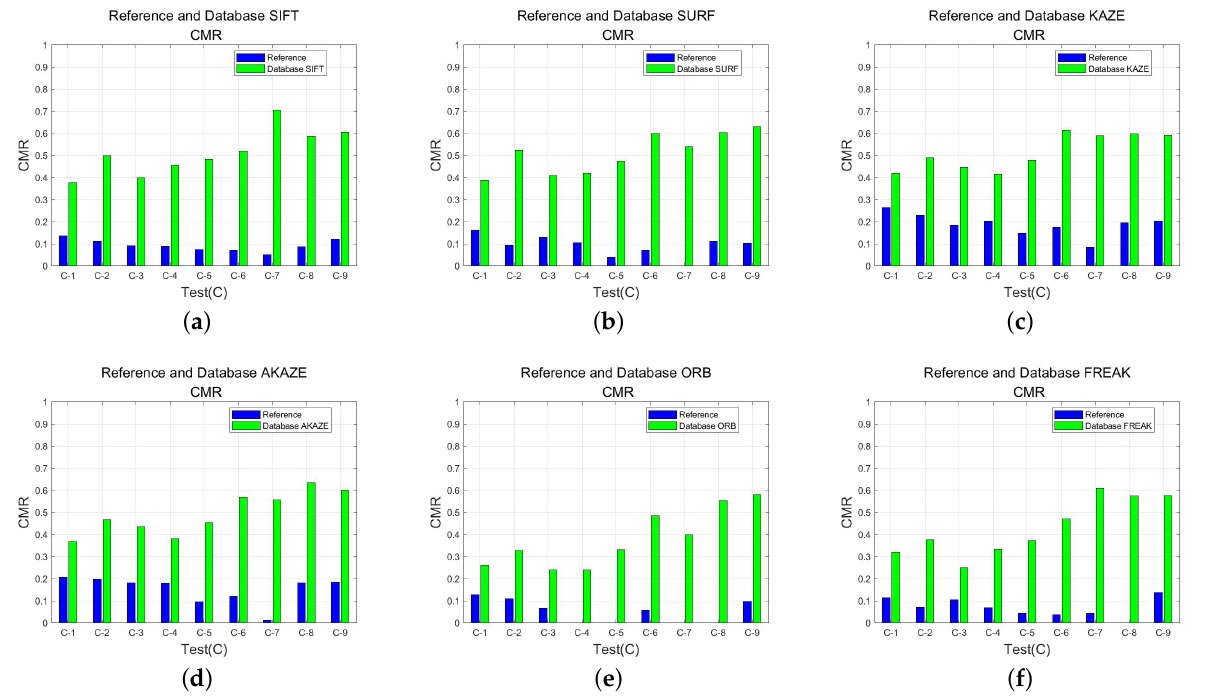
Figure 7. CMR comparison of the direct matching method and the feature database matching